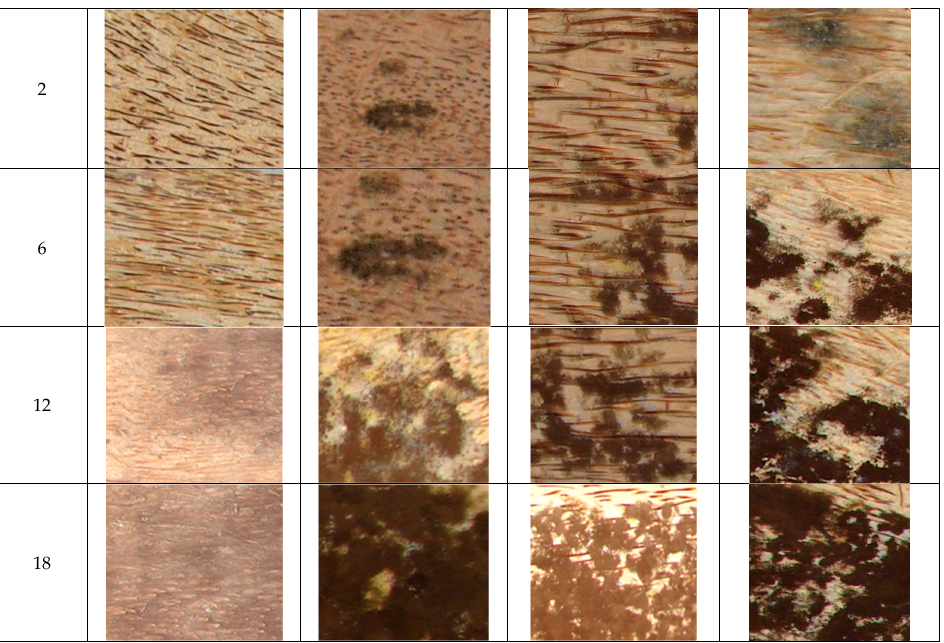
Figure 3. Surface color of oil palm samples immersed in tap water for 48 h, and thereafter conditioned in a kiln to varying MCs at a thickness of 40 mm. These results indicate that at a higher MC, discoloration increases with an increase in duration.